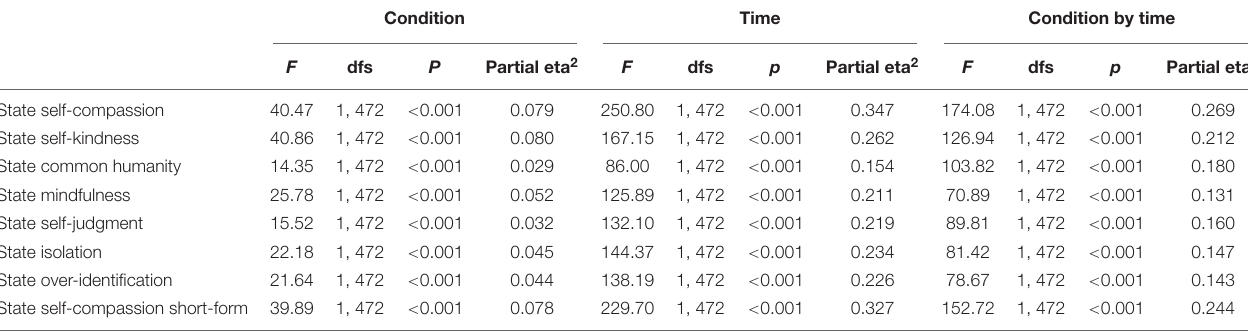
TABLE 9 | Statistics for the repeated-measures analyses of variance for SSCS-J. Condition Time Condition by time F dfs P Partial eta 2 F dfs p Partial eta 2 F dfs p Partial eta